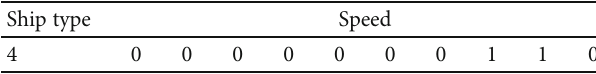
Table 3: The freight rates between ports r